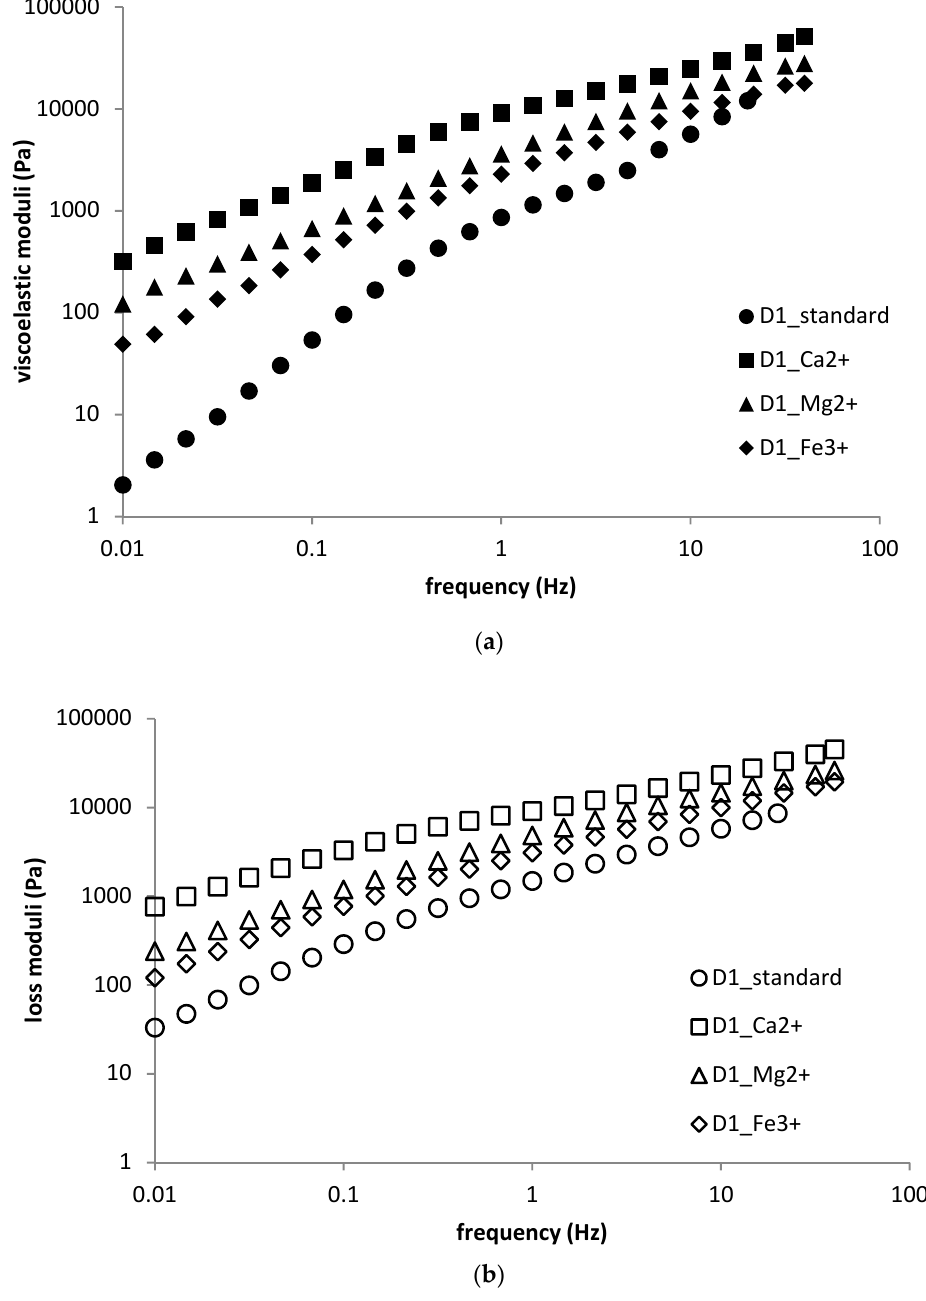
Figure 8. ( a ) Frequency sweep (storage moduli) for D1 sample—the e ff ect of multivalent ions; ( b ) frequency sweep (loss moduli) for D1 sample—the e ff ect of multivalent